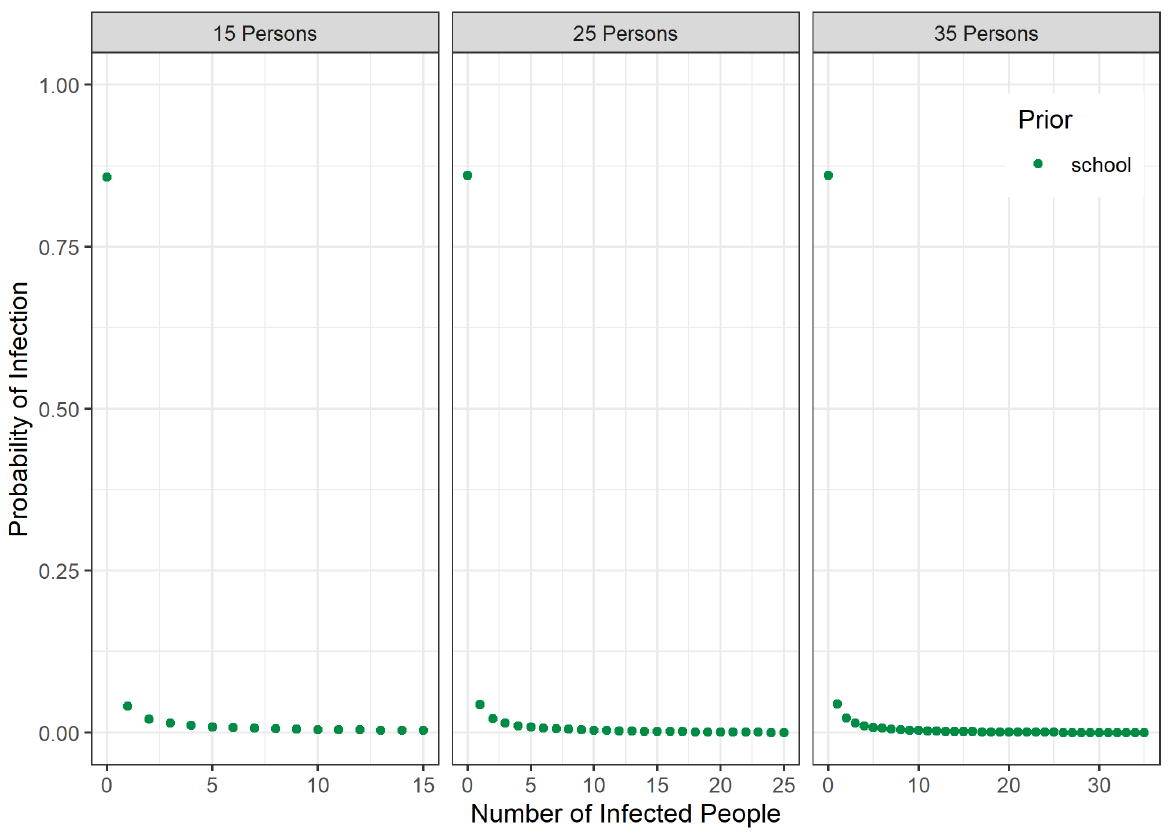
Figure 2. Plots of the Beta-binomial distribution as school class prior for M = 15,25,35.